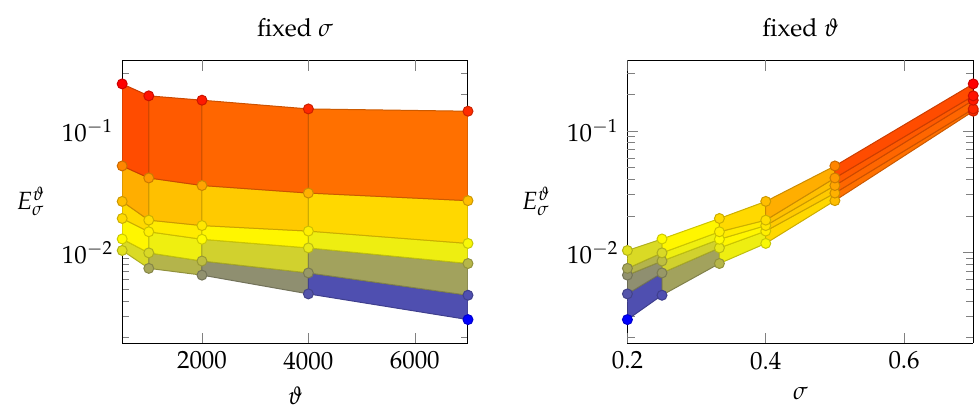
Figure 6. DFN158. Example for the case ( α = 2, β = 1 ) . Three-dimensional plot projections in order to observe the behavior of E ϑ σ while maintaining fixed σ ( left ) or ϑ ( right ). E ϑ σ points are reported in logarithmic scale.